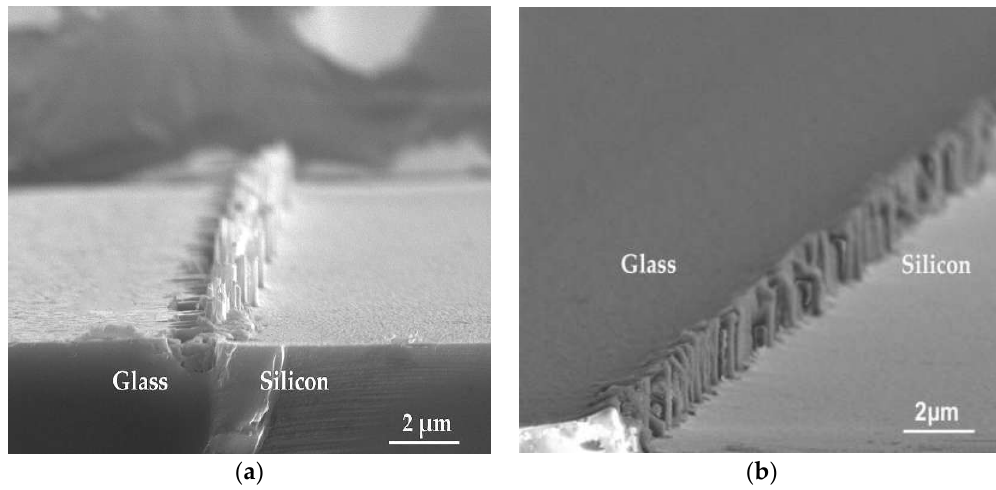
Figure 3. SEM view near glass-silicon interfaces at the bottom surfaces of the cavities after etching. ( a ) Buffered hydrofluoric acid (BHF) for glass etching, and etching time was 8 minutes; ( b ) HF/HCl/DI.H2O (deionized water) solution for glass etching, and etching time was 1 minute.